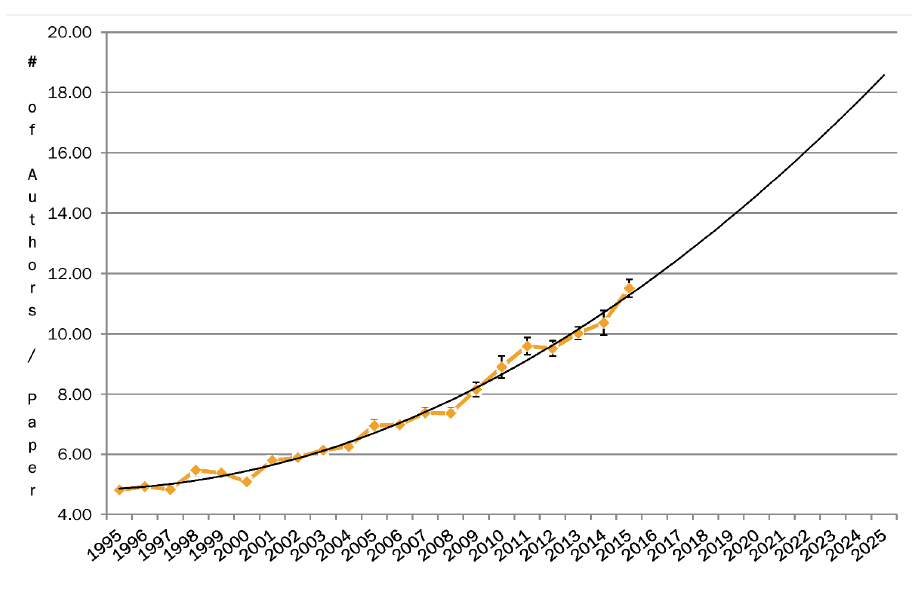
Figure 2. Average # of Authors per paper by # of authors